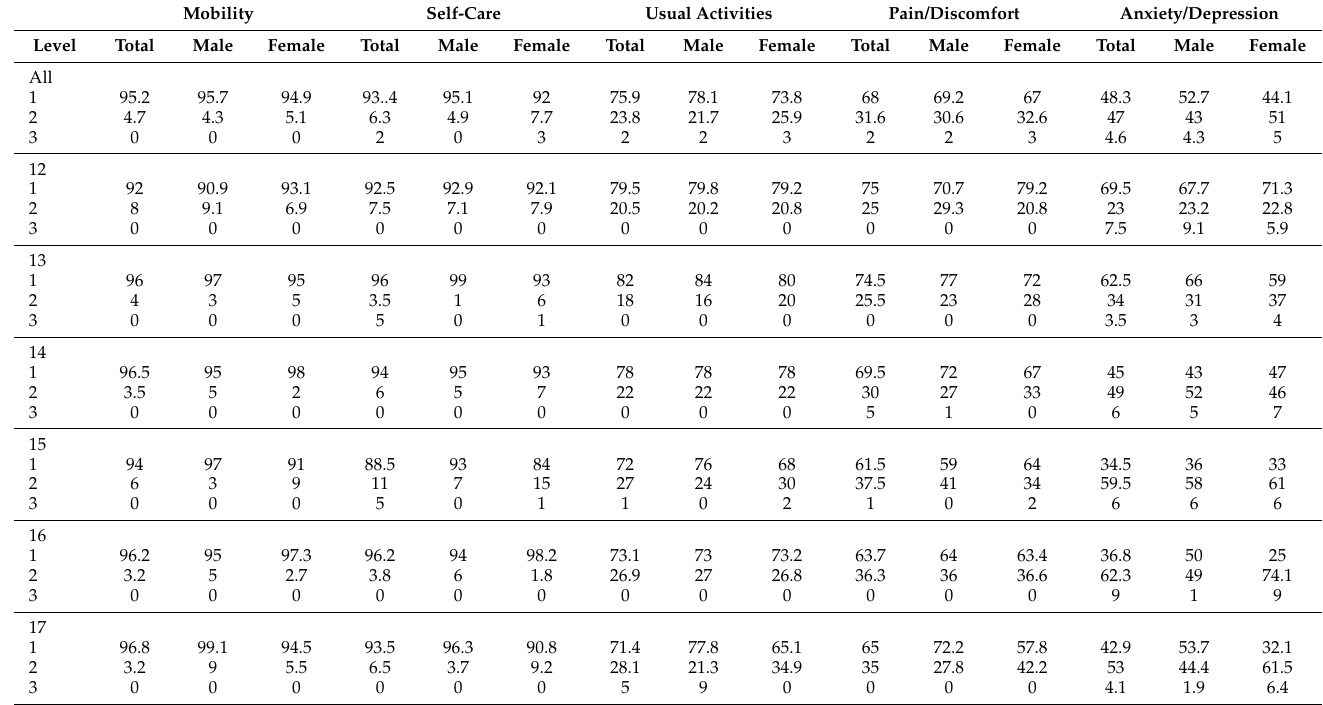
Table 3. Percentage frequency distributions of EQ-5D-Y dimensions by gender and age